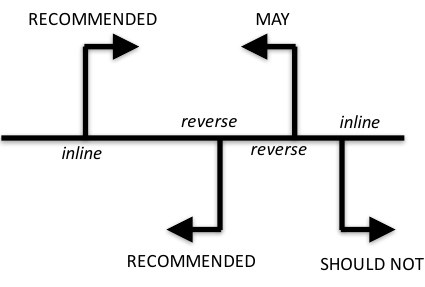
Figure 10: Use of glyph orientation to indicate inline vs. reverse complement direction.